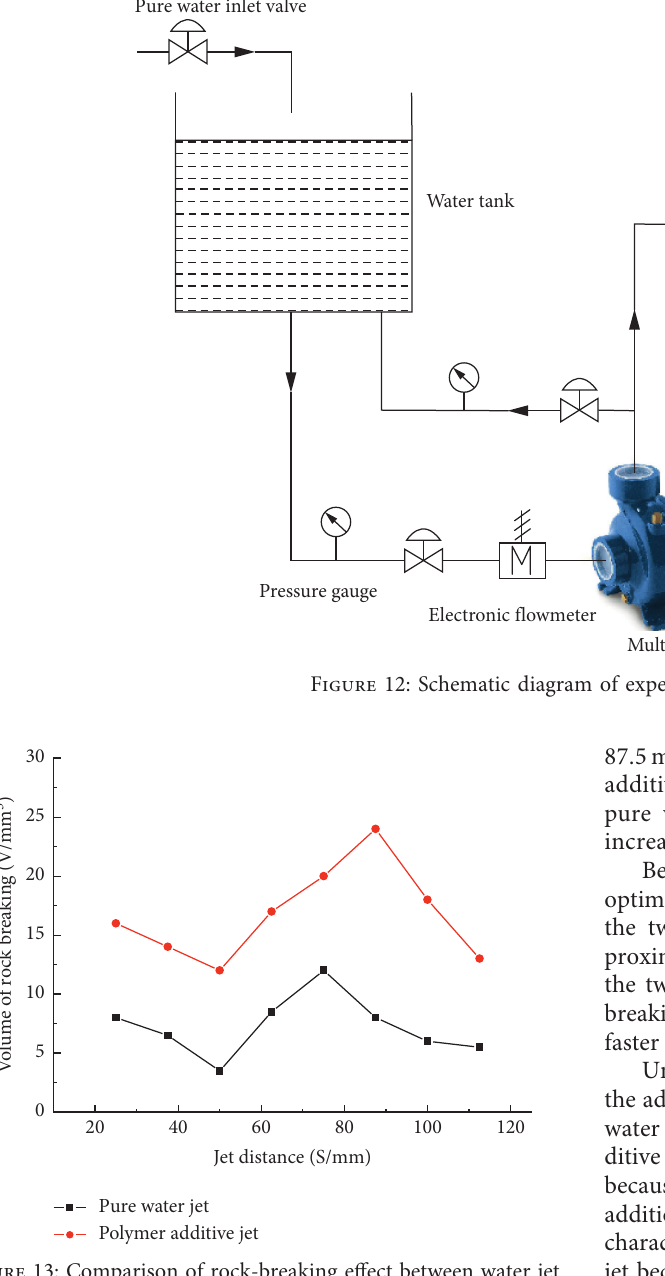
Figure 13: Comparison of rock-breaking effect between water jet and polymer additive